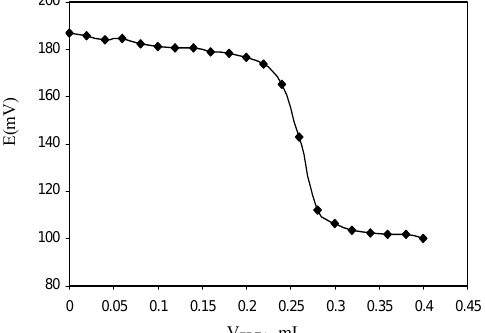
Figure 5. Potential titration curve of 25.0 mL from a 1.0 × 10 -4 M Ho 3+ solution with 1.0 × 10 -2 M of EDTA